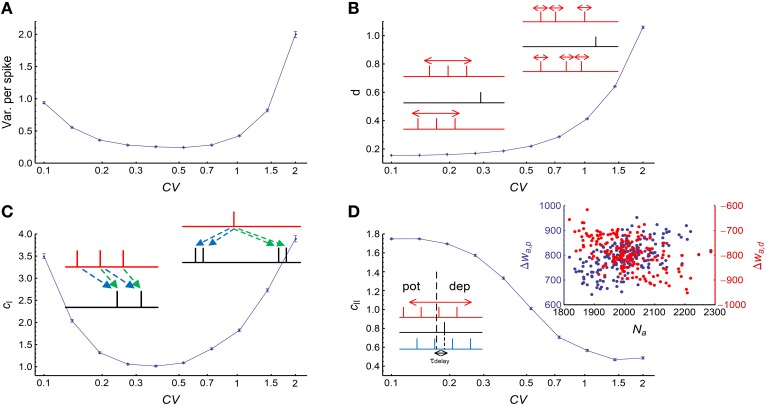
The influence of auto-correlation structure onto DiffV in stationary spike trains. (A) Variance per spike (ET[Vara(Δwa)]∕N¯0, see Equation 10) as a function of CV, when spike trains are generated according to Model Auto (see Section 2). (B)
d as a function of CV. Left inset: when the non-central spike trains are regular, the non-central spikes move left or right almost simultaneously. Right inset: when the non-central spike trains get bursty, each spike can move with a larger freedom, thereby contributing to the increase of DiffV. Black lines in the insets represent the central spike train, and colored (here, red) lines represent the non-central spike trains: the same color scheme is also used in the insets of the following panels. (C)
cI as a function of CV. Left inset: when the spike trains are regular, the synaptic updatings caused by adjacent central spikes are correlated because of transient cross-correlation. Right inset: when the central spike train gets bursty, the synaptic updatings caused by adjacent spikes in the same bursting events are correlated. Dashed arrows of the same color in the two insets represent similar synaptic updatings during STDP. (D)
cII as a function of CV. Left inset: when the non-central spike trains are regular, the spikes that potentiate and depress the synapses move left or right almost simultaneously, which correlates the total potentiation and depression values. In this inset, the red spike train cause weaker potentiation and stronger depression than the blue spike train. Right inset: when the spike trains are bursty (here, CV = 2), the spike number of a non-central neuron (horizontal coordinate) is positively correlated with the total potentiation (blue) value and negatively correlated with the total depression (red) value. In (A–D), error bars represent s.e.m., the converging motif has 200 non-central neurons. Parameters for STDP: Ad = Ap = 1 (see Figure 2B and Equation 6 in Section 2). All synaptic efficacies were 0 at the beginning, and simulations were run for 100 s biological time, with 32 trials.